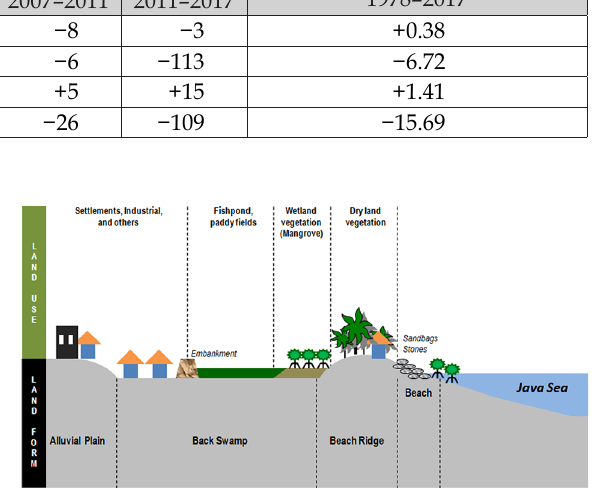
Fig. 6. The relationship between coastal landform profile and land use in the study area.